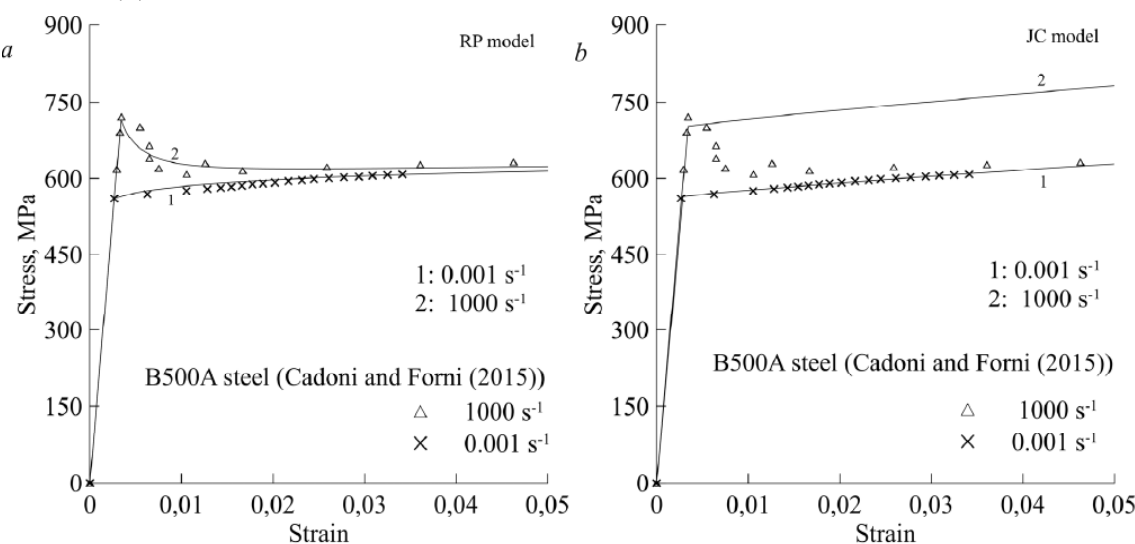
Fig. 10. Stress-strain dependences of B500A steel [6] on strain rates 0.001 s –1 and 1000 s –1 , predicted by the RP model (a) and the JC model